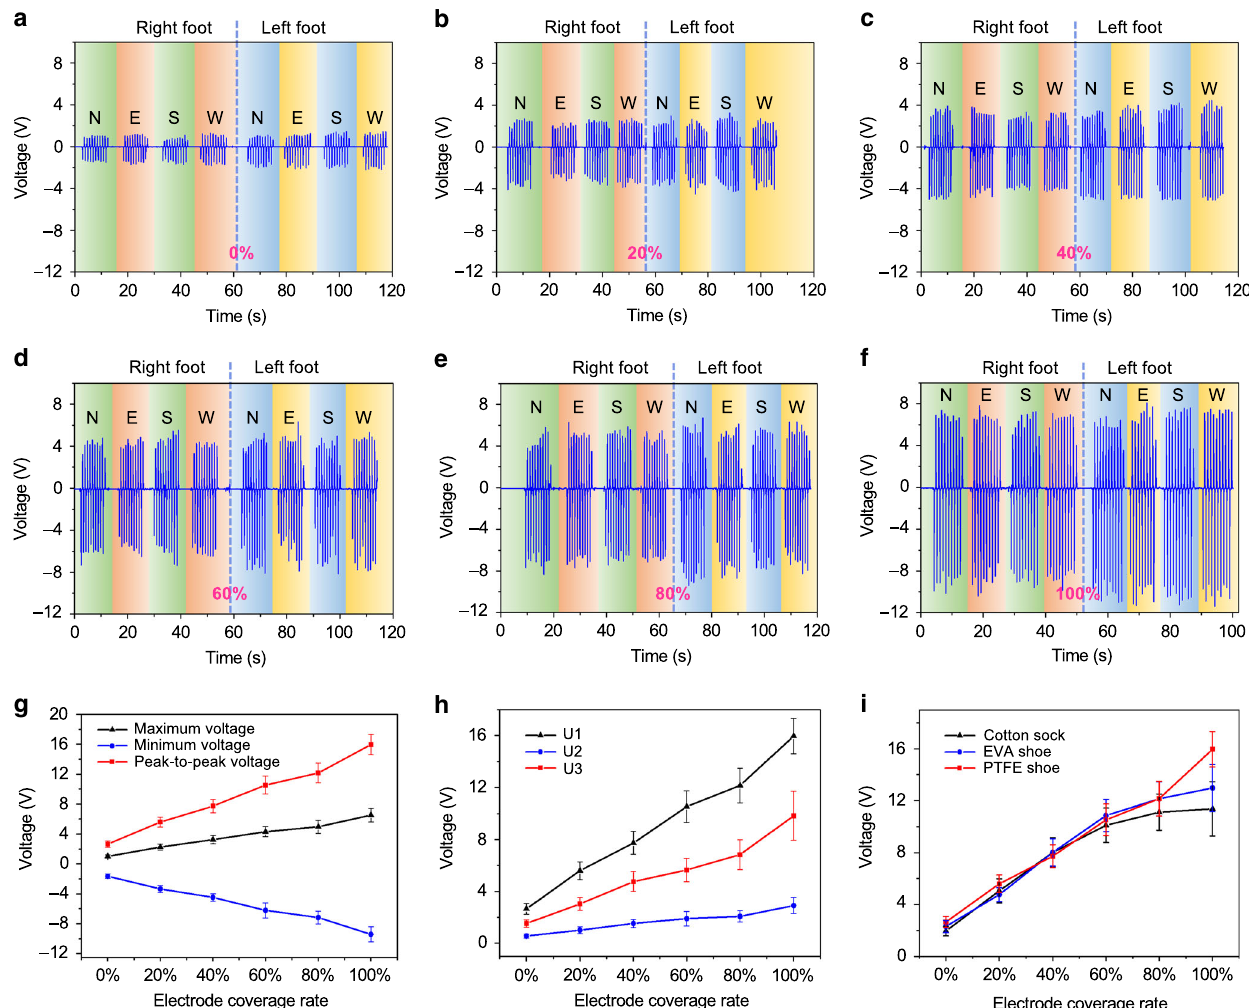
Fig. 2 Characteristics of the output performance of the individual DLES-mat on a 1 M Ω external load. a – f The generated voltages by repeated stepping motions with polytetra fl uoroethylene (PTFE) shoes (four directions toward the north, east, south, and west for both the right foot and the left foot) on DLES-mats with an electrode coverage rate of a 0%, b 20%, c 40%, d 60%, e 80%, and f 100%. g The corresponding maximum voltage, minimum voltage, and peak-to-peak voltage from Fig. 2a – f with respect to different electrode coverage rates, showing clear increment trends with the increased electrode coverage rate. The error bars indicate the standard deviation. h The effect of different users wearing PTFE shoes on the output peak-to-peak voltage. Similar increment trends of relative magnitudes can be observed from different users, indicating the suitability of the DLES-mat design for individual position sensing. i The effect of different contact materials worn by the same user on the output peak-to-peak voltage, where similar increment trends can also be